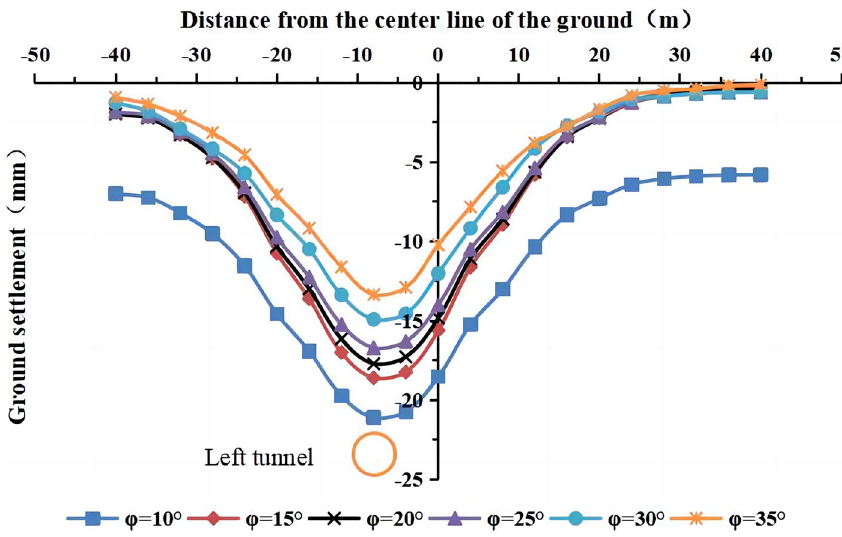
Figure 22. Surface settlement during single-line excavation for different internal friction angles.